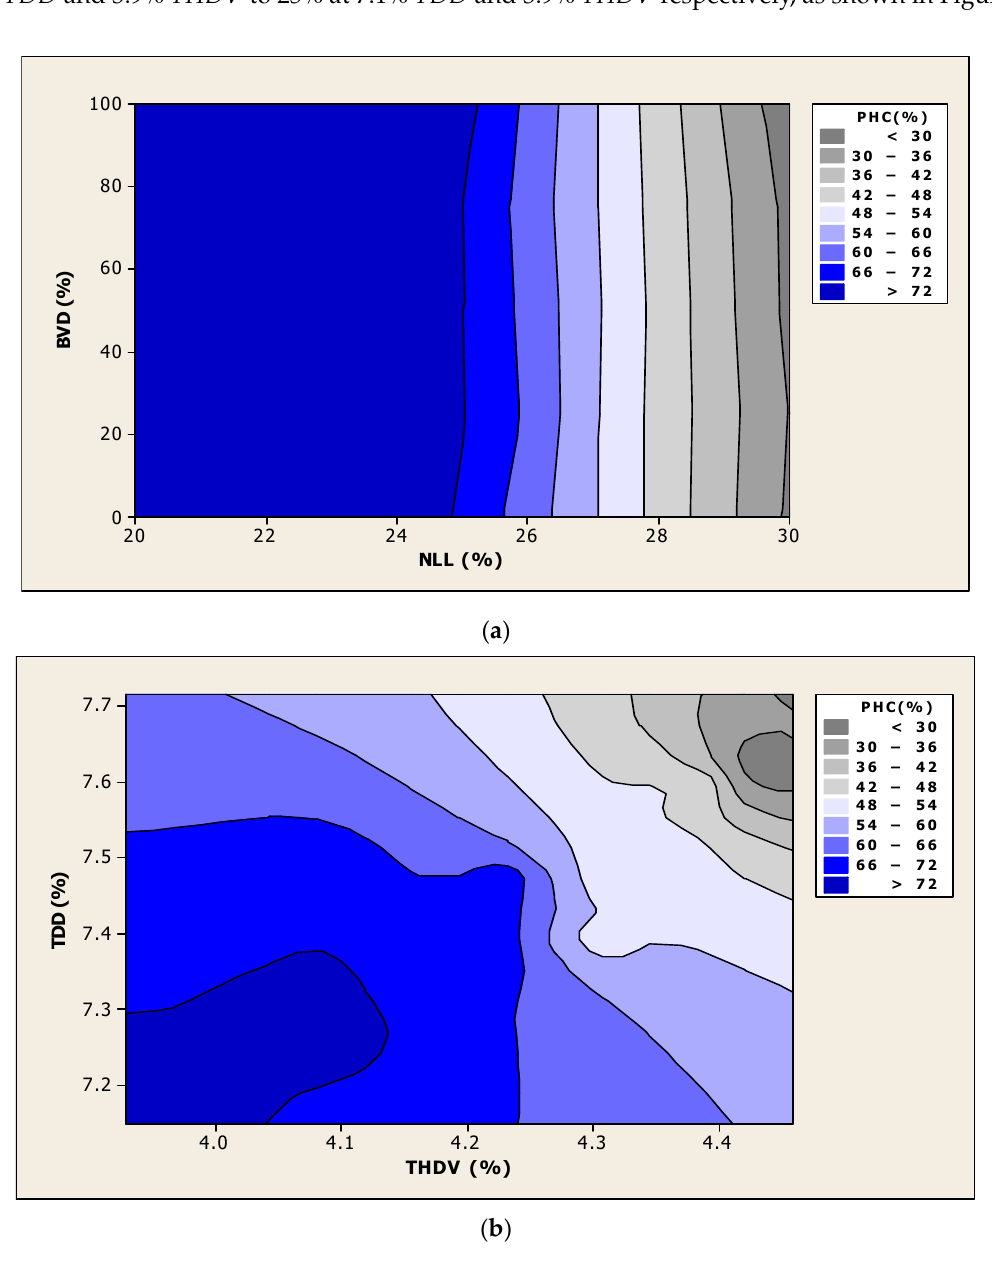
Figure 9. Contour plots of operational performance indices and the corresponding PHC levels: ( a ) PHC (%) versus NLL (%) and BVD (%), ( b ) PHC (%) versus TDD (%) and THDV (%).